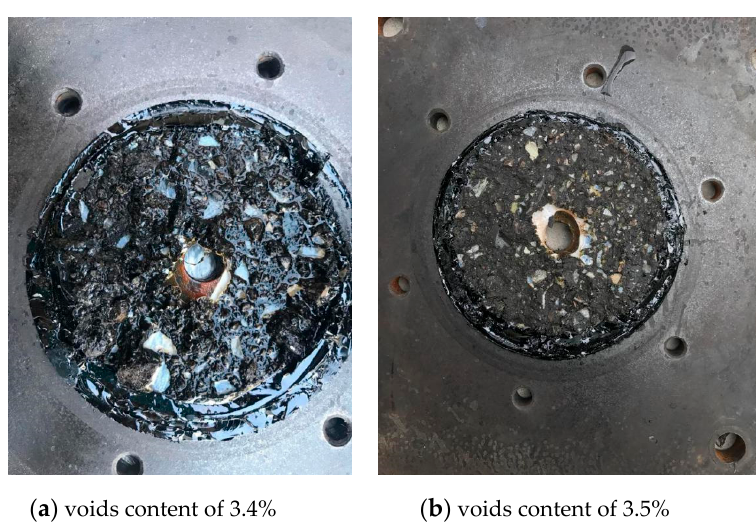
Figure 9. Test process for the specimen with a voids content of 3.5%.